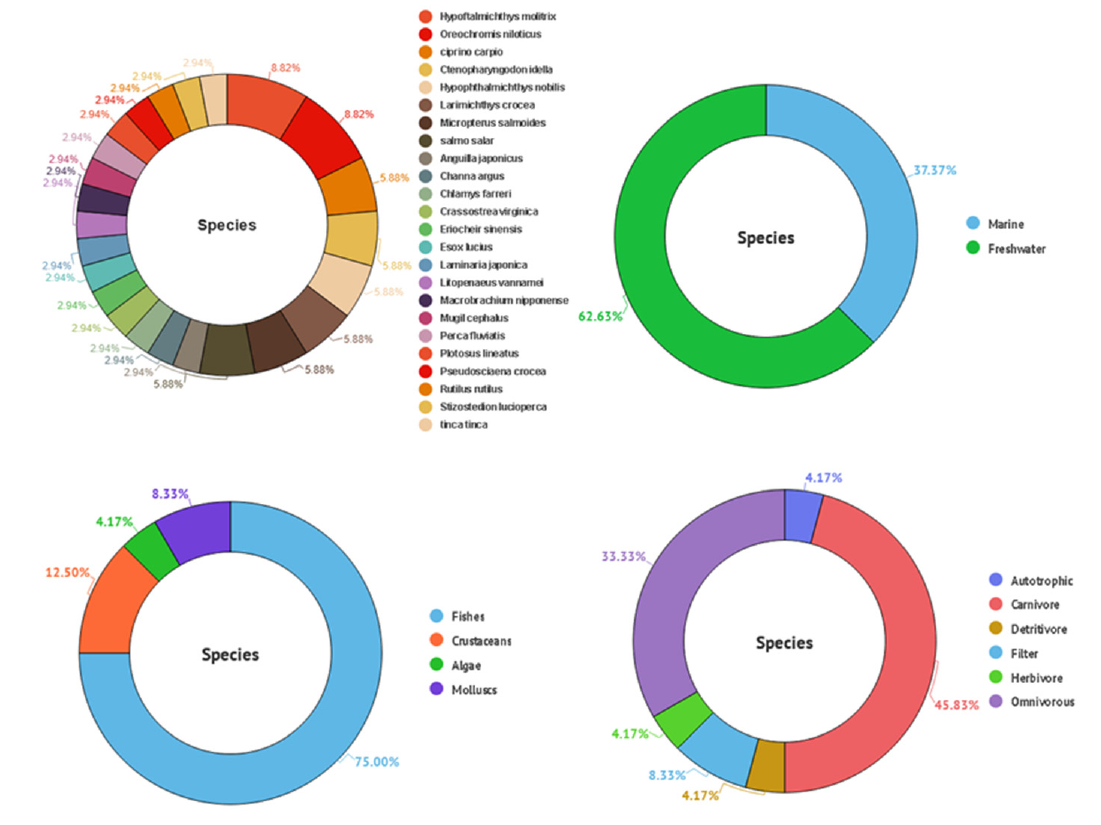
Figure 7. Description of aquatic organisms in articles evaluated with Emergy.